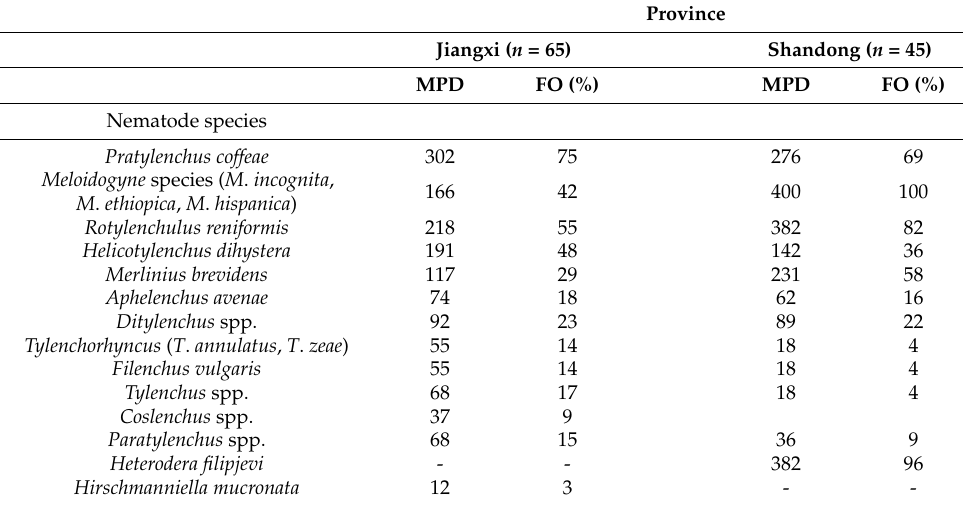
Table 2. Mean population densities (MPD), and frequencies of occurrence (FO) of plant-parasitic nematodes species isolated from 100 mL of rhizosphere soil sampled from yam plants in nine locations of Jiangxi and Shandong provinces across south-east China during 2020/2021.